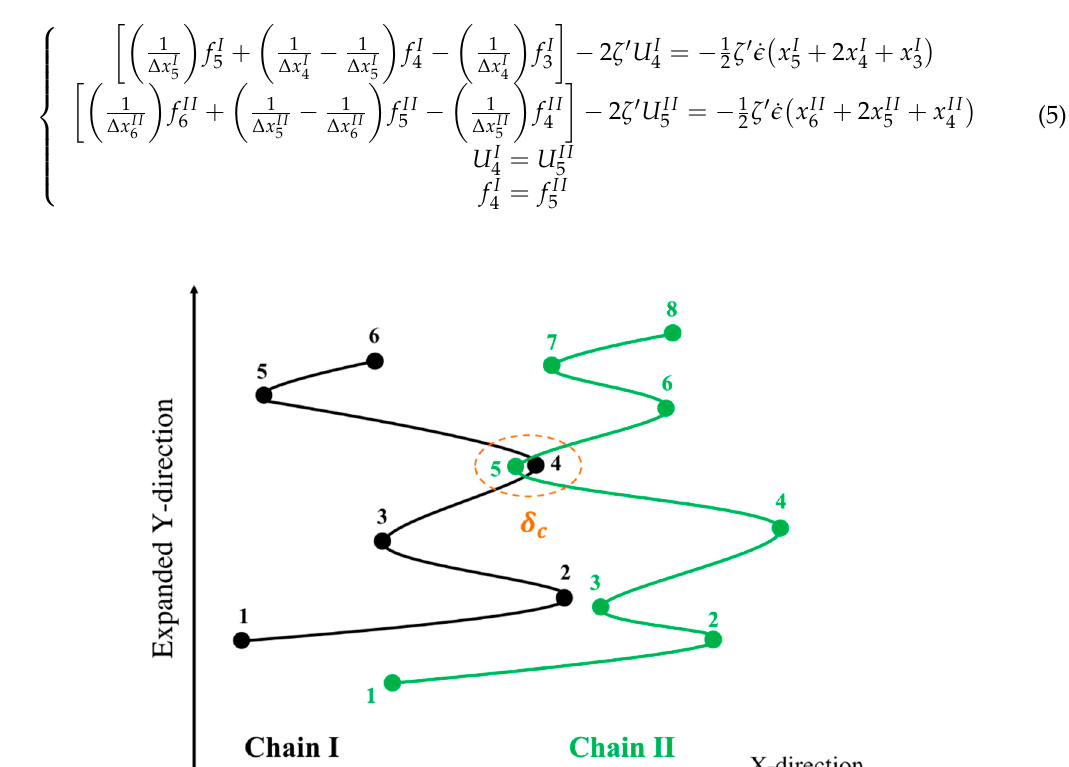
Figure 1. Schematic of an entangled kink between two chains in EKD model. The Y-direction above is arbitrarily expanded for clarity. Figure is adapted from [18] with permission, copyright American Chemical Society, 2019.